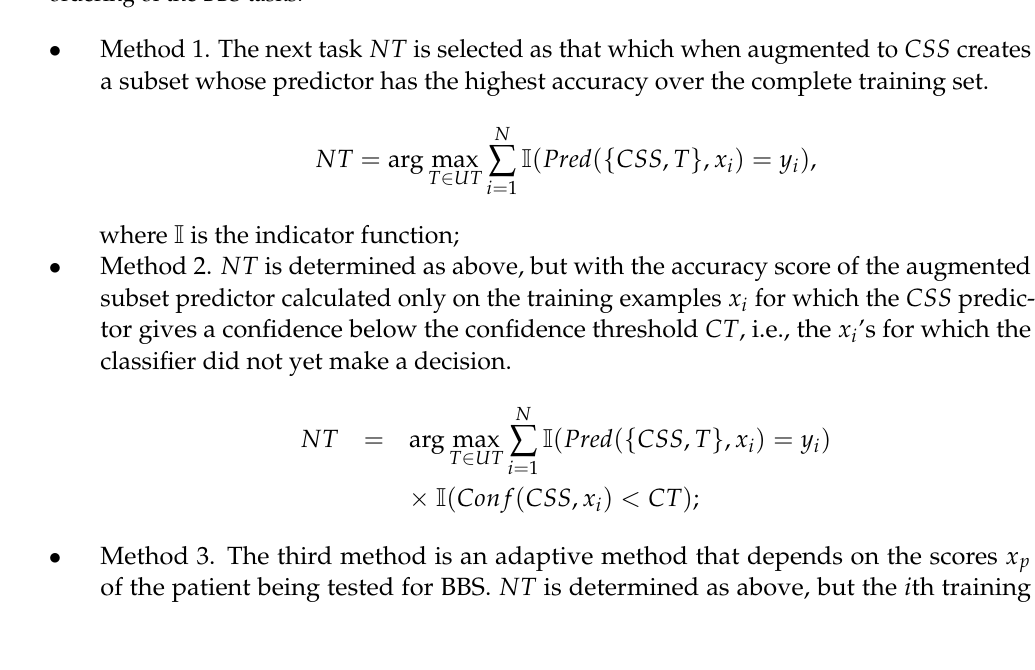
Figure 6. Schematic diagram of the E-BBS fall risk prediction system with efficient and adaptive ordering of the BBS